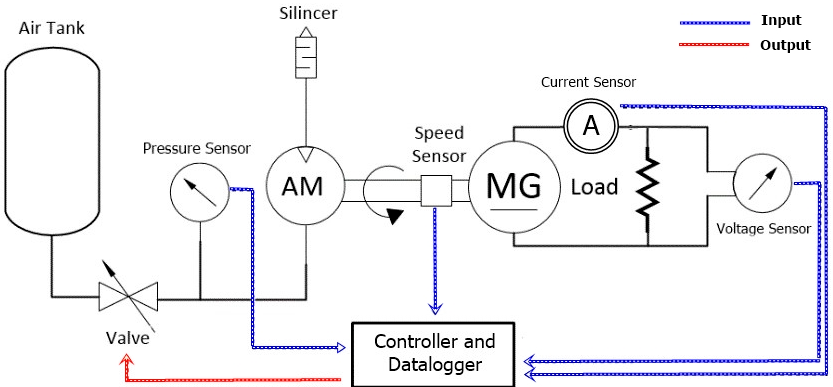
Figure 1. Block diagram of prototype small scale compressed air energy storage (SS-CAES).